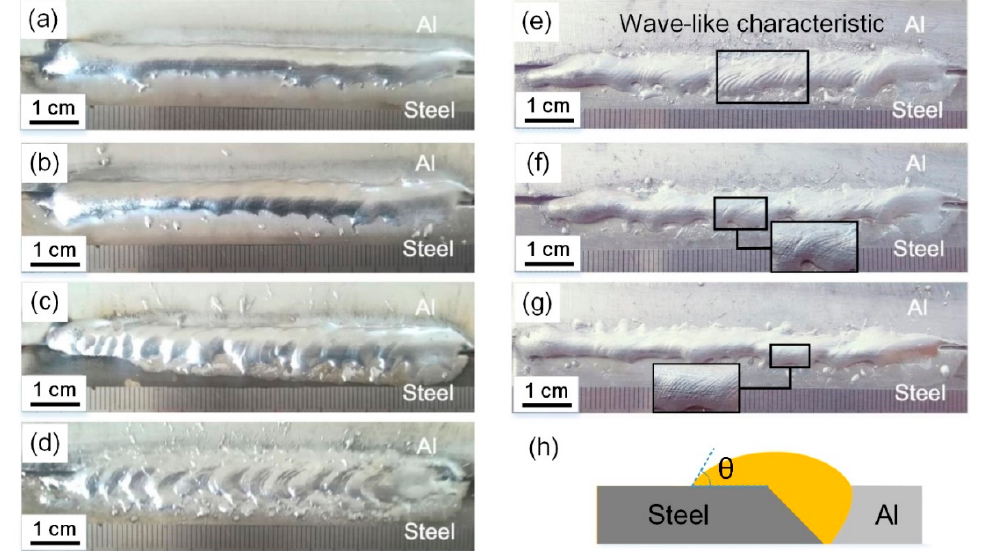
Figure 2. Weld appearances of Al/steel joints at different magnetic field parameters: ( a ) 0 A, 0 Hz; ( b ) 1 A, 0 Hz; ( c ) 2 A, 0 Hz; ( d ) 3 A, 0 Hz; ( e ) 2 A, 5 Hz; ( f ) 2 A, 10 Hz; ( g ) 2 A, 15 Hz; ( h ) schematic diagram of wetting angle ( θ ).